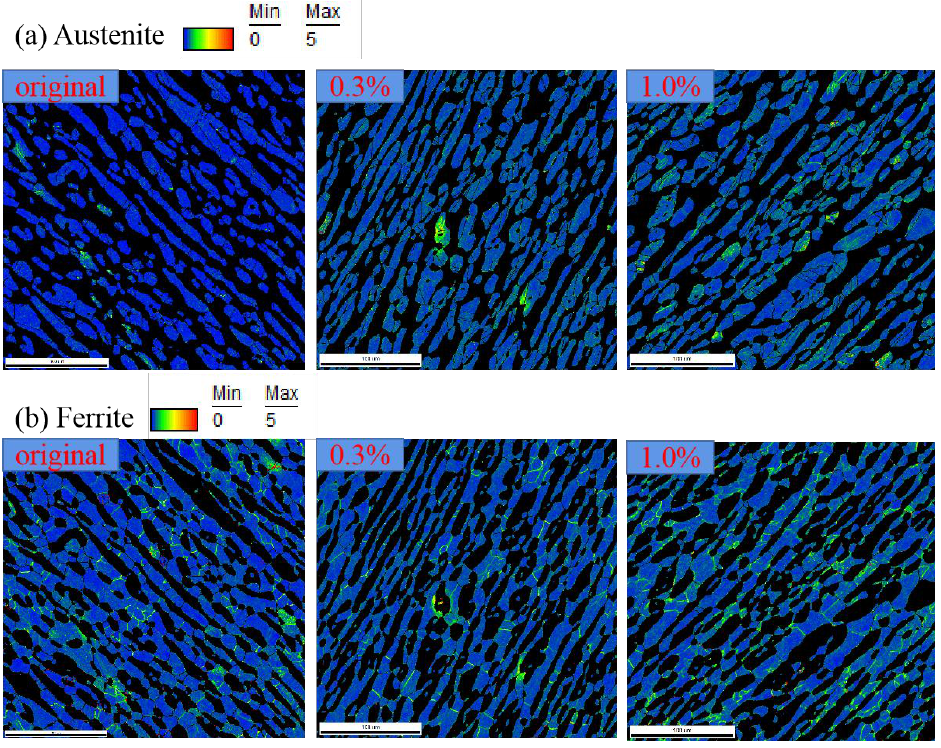
Figure 11. Distribution of KAM within two constitutive phases for 2205 under different strain amplitudes: ( a ) austenite and ( b ) ferrite.